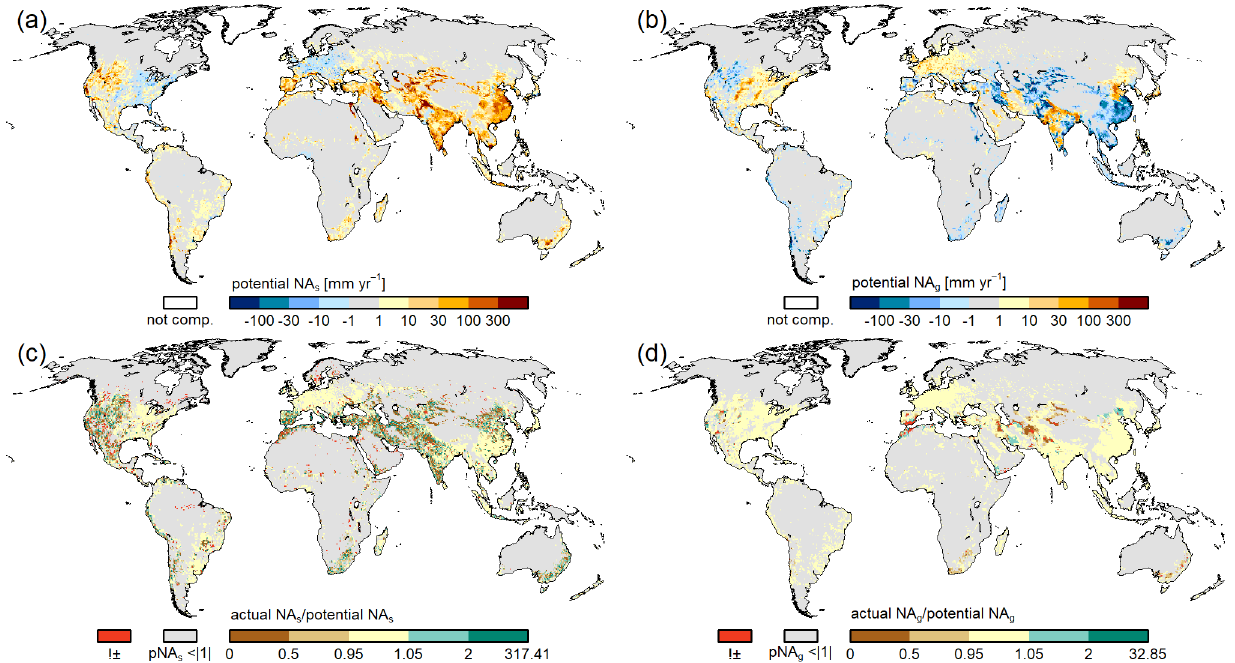
Figure 15. Long-term (1981–2010) annual net abstractions: potential net water abstractions from surface water bodies (a) , potential net water abstractions from groundwater (b) , ratio of actual net water abstractions from surface water bodies to its potential value (c) and ratio of actual net water abstractions from ground water to its potential value. In (a) and (b) negative values indicate a net recharge of surface water and groundwater, respectively, due to return flows caused by human water use, while positive values indicate a net removal of water from the sources. In (c) and (d) , cells with potential net water abstractions smaller than | 1 | mmyr − 1 are greyed out. Furthermore, grid cells where the sign of water abstractions changes between potential and actual net abstractions are displayed in